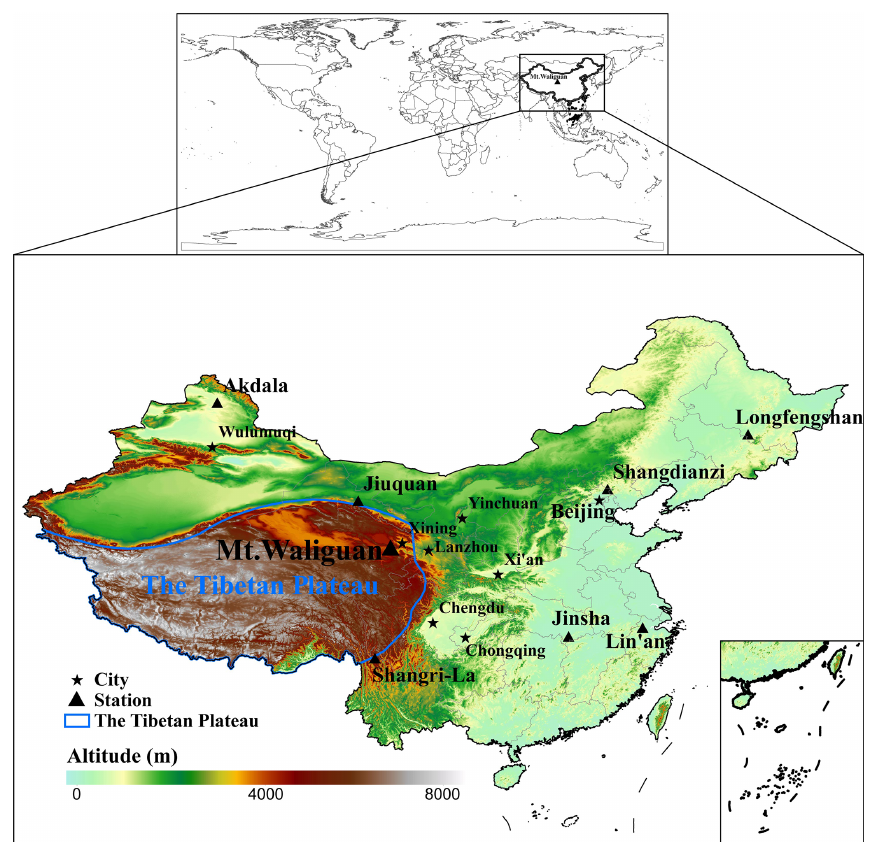
Figure 1. The location of Mt. Waliguan (WLG) World Meteorological Organization (WMO) and Global Atmosphere Watch (GAW) global station and the other regional stations in China. The gradient color indicates altitude. The digital elevation model (DEM) was downloaded from the Geospatial Data Cloud site, Computer Network Information Center, Chinese Academy of Sciences (http://www.gscloud.cn, last access: 22 September 2018), and then processed by ArcGis software. The China 1094 map was derived from the ©National Geomatics Center of China (http://www.ngcc.cn/ngcc/, last access: 17 March 2018). The world map was obtained from ©OpenStreetMap contributors 2019 and is distributed under a Creative Commons BY-SA license (https://www.openstreetmap.org/, last access: 18 February